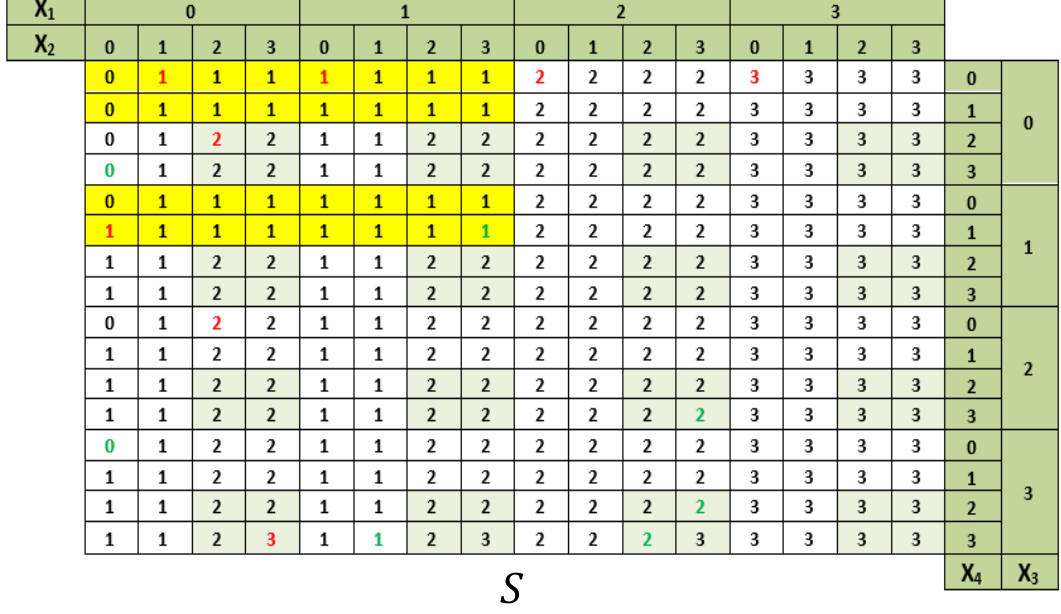
Figure 2. The MVKM of Figure 1 redrawn to highlight the relation between a prime implicant of success (failure) at level 2 and its characterizing minimal upper vector (maximal lower